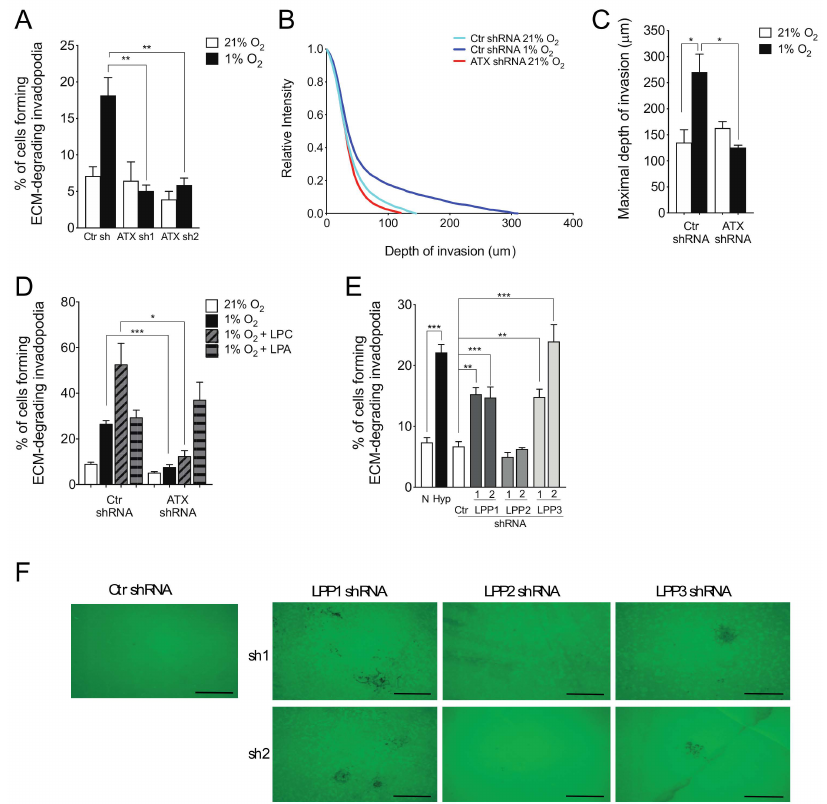
Figure 3. Role of ATX and LPPs in cancer cell invasion. ( A ) Cells transfected with non-targeting control (Ctr) or one of two ATX-targeted shRNA constructs (sh1 or sh2) were cultured for 10 h on fluorescently-labeled gelatin. The percentage of cells forming extracellular matrix (ECM)-degrading invadopodia is shown for cells cultured in normoxia (21% O 2 ) or hypoxia (1% O 2 ) N = 3. ( B – C ) Cells transfected with non-targeting (Ctr) or ATX-targeted shRNA were incubated on type I collagen in 3D invasion assays in normoxia (21% O 2 ) or hypoxia (1% O 2 ) for 24 h. ( B ) The relative intensity of cell staining according to depth of invasion is shown. ( C ) The maximal depth of invasion is shown for each condition. ( D ) Cells transfected with non-targeting control (Ctr) or ATX-targeted shRNA were incubated in normoxia (21% O 2 ), hypoxia (1% O 2 ), hypoxia with LPC 10 µ M (1% O 2 + LPC), or hypoxia with LPA 10 µ M (1% O 2 + LPA). The percentage of cells forming ECM-degrading invadopodia is shown, N = 3. ( E , F ) HT1080 cells incubated in normoxia (21% O 2 ) or hypoxia (1% O 2 ), or HT1080 cells transduced with non-targeting control (Ctr) or one of two LPP1-, LPP2-, or LPP3-targeted shRNA constructs incubated in normoxia (21% O 2 ) were cultured for 10 h on fluorescently-labeled gelatin. ( E ) The percentage of cells forming ECM-degrading invadopodia and ( F ) representative images of matrix degradation are shown. N = 3. Bars represent the mean ± SEM (* p < 0.05, ** p < 0.01, *** p < 0.001). Scale bars, 50 µ